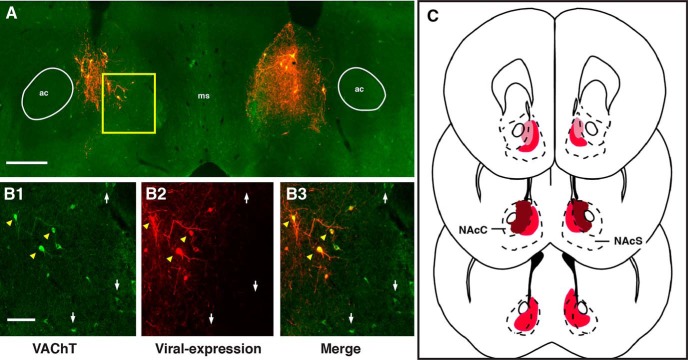
Selective expression of viral constructs in NAc cholinergic interneurons. Viral targeting of NAc-CINs in ChAT-cre mice resulted in selective expression of MCY (B2) in neurons expressing the vesicular ACh transporter VAChT (B1, B3) in the medial core and shell region of the NAc (n = 10; A, C). C, Darker shading corresponds to the qualitative greater density of the dendritic and somatic extent of ACh-CIN labeling. ac, anterior commissure; ms, medial septum; NAcC, nucleus accumbens core; NAcS, nucleus accumbens shell. White arrows, VAChT-expressing neurons; yellow arrowheads, neurons expressing both VAChT and MCY. Scale bars: A, 100 μm; B, 0.5 mm.